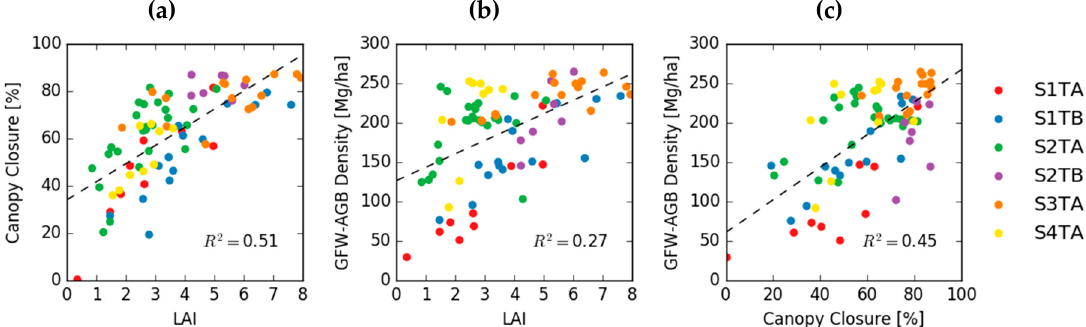
Figure 12. ( a ) Relationship between LAI and canopy closure measured at transect points; ( b ) transect LAI ( x -axis) versus GFW-AGB density ( y -axis); ( c ) transect canopy closure ( x -axis) versus GFW-AGB density ( y -axis). Color of points corresponds to transect. Linear best-fit lines shown in dashed black, with r-squared values reported.